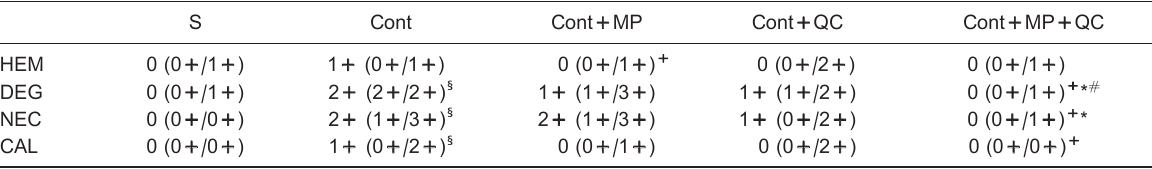
Table 3. Comparison of groups according to histopathological findings.